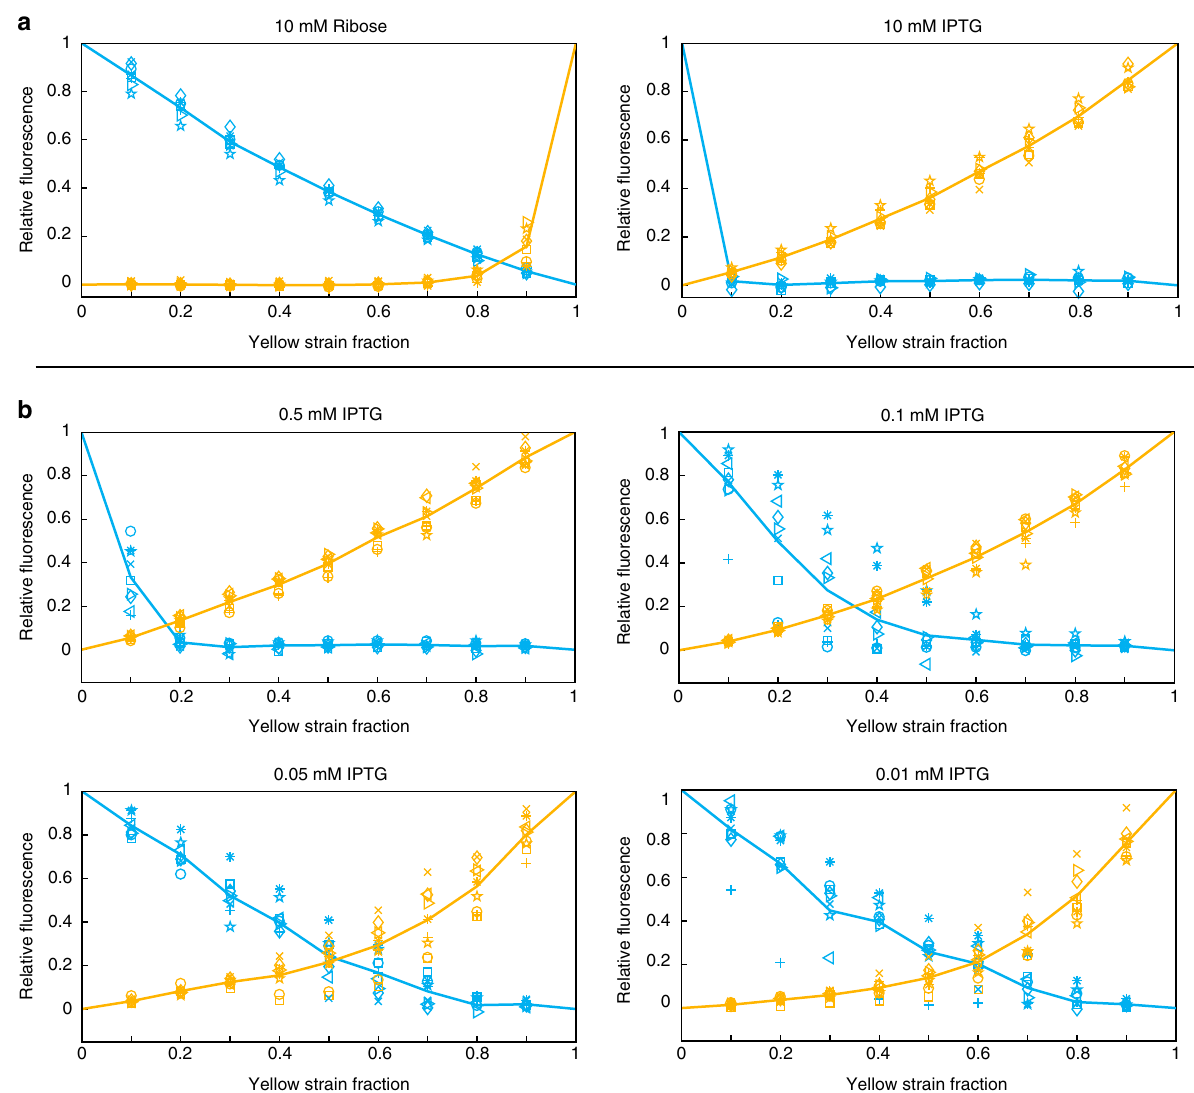
Fig. 3 Inducer effect on the majority wins pattern. a Relative cyan (blue curve) and yellow (yellow curve) fl uorescence as a function of strain fraction in the presence of 10 mM ribose (left) or 10 mM IPTG (right) ( n = 9). Full induction with 10 mM ribose or IPTG induces the respective strain regardless of strain fraction. Fluorescences are normalized to maximum values from wells containing a single strain of the respective color (100% wells). Normalization of these data to strain ratio is presented in Supplementary Fig. 6a to account for the change in number of cells containing the fl uorescence gene. b Decreasing amounts of IPTG shift the fl uorescence curves differently and alter the majority wins pattern less ( n = 9). See Supplementary Fig. 1 for corresponding modeling data showing the modulation of cross over point with inducer. For each of the above graphs, similar symbols with different colors represent the yellow and cyan intensities from the same well of the same replicate experiment and lines represent averages across all replicates. Further, fl uorescences are normalized to maximum values from wells containing a single strain of the respective color (100% wells). Normalization of these data to strain ratio is presented in Supplementary Fig. 6b to account for the change in number of cells containing the fl uorescence gene. Source data are provided as a Source Data fi